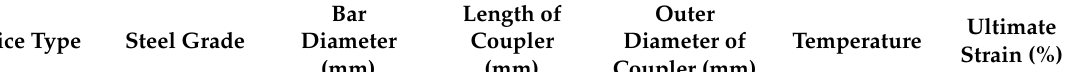
Table 1. Pearson coefficients determined for the input and output